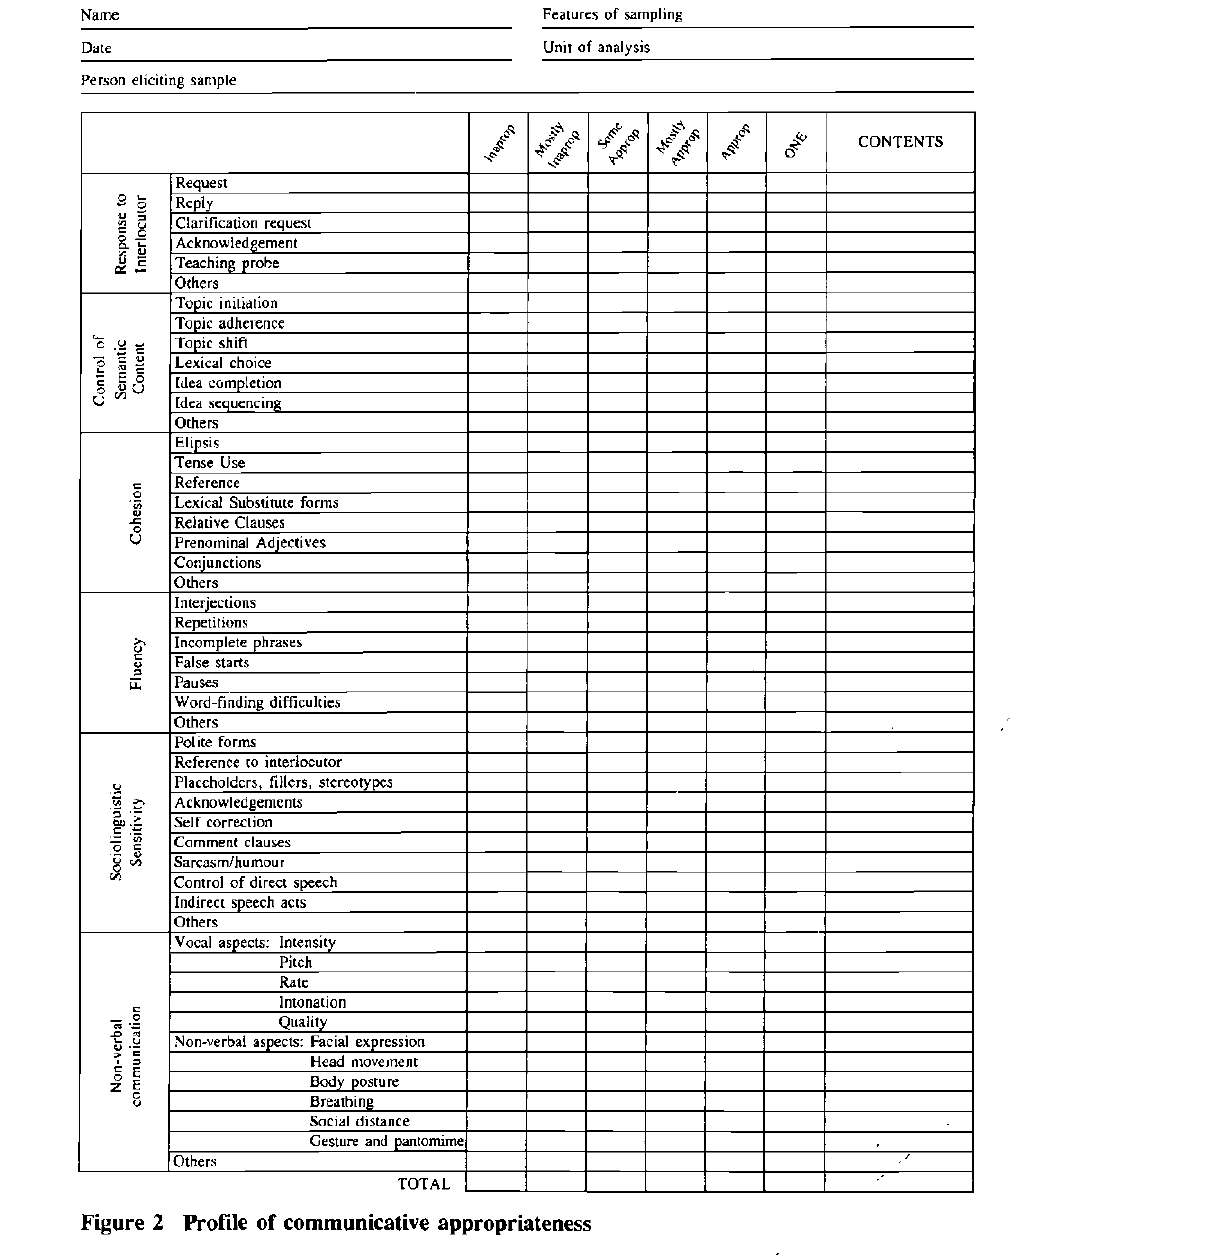
Figure 2 Profile of communicative